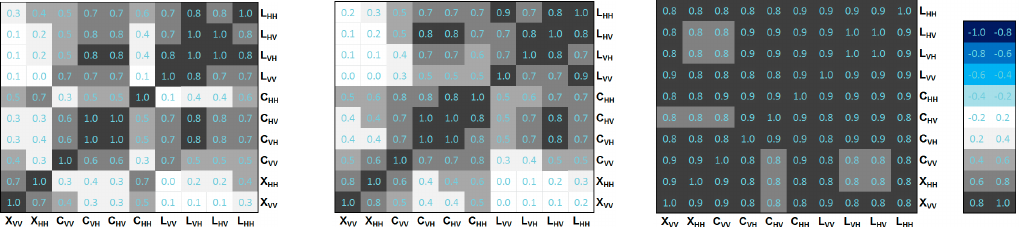
Figure 8. r s domain for plot 460 at three selected dates: 19th April (left panel), 7th June (central panel) and 26th July (right panel). The dichromatic color ramp describes very strong negative to very strong positive correlations (from blue to grey). Values of r s rounded to first decimal place are also reported.